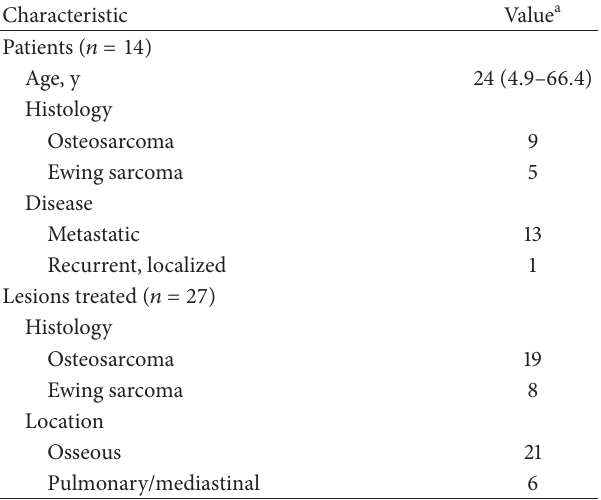
Table 1: Patient and tumor